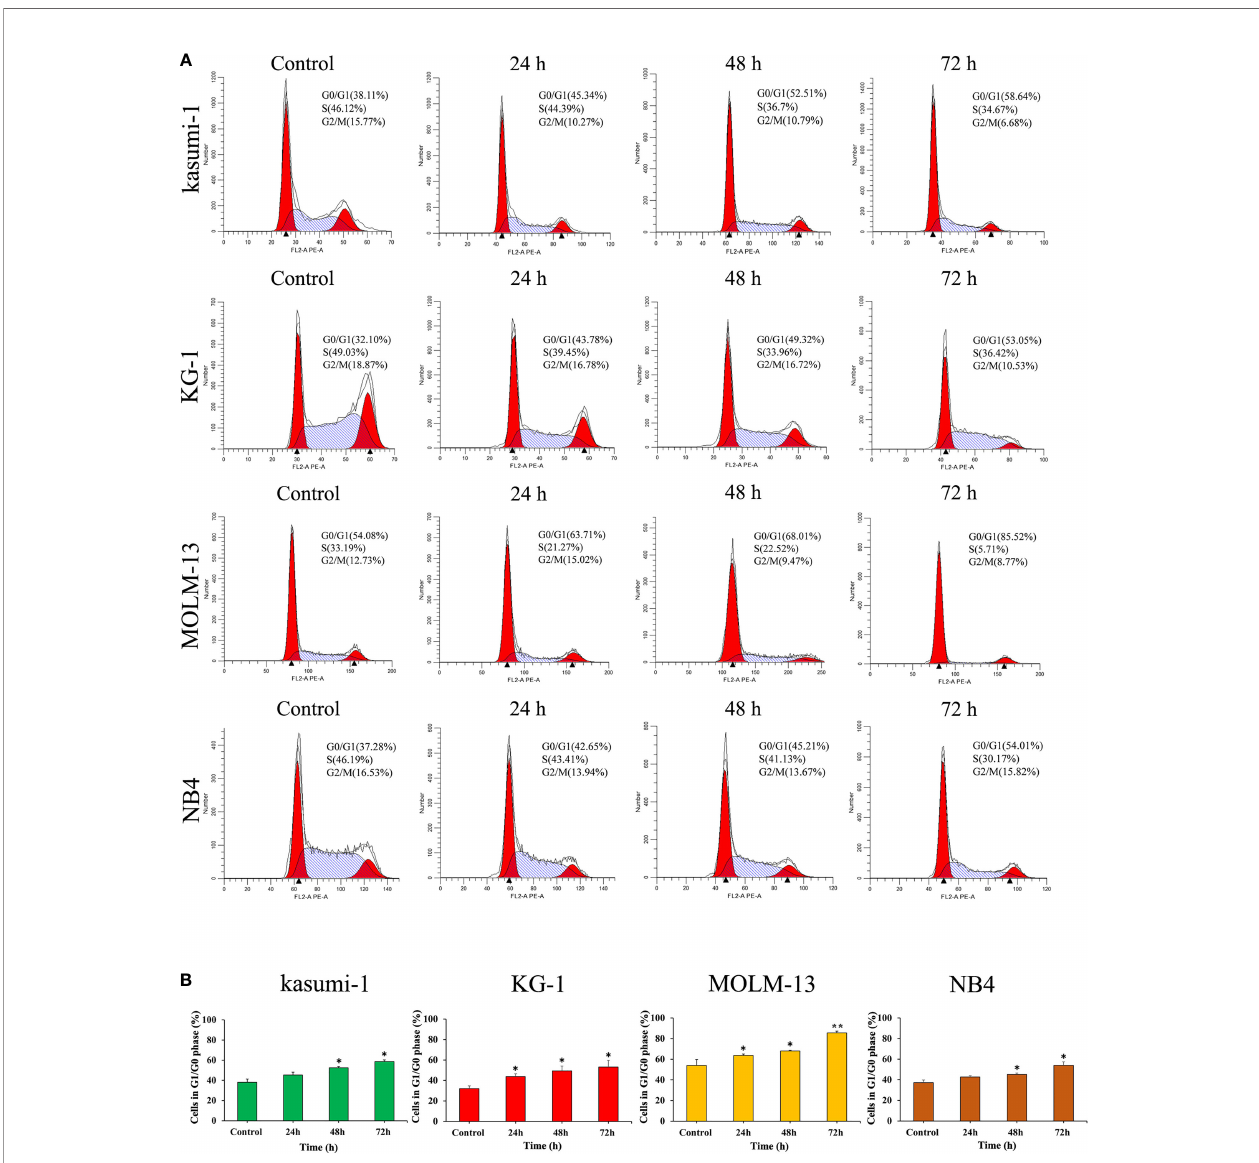
FIGURE 3 | I13 induced the cell-cycle exit in Kasumi-1, KG-1, MOLM-13 and NB4 cells. (A) Kasumi-1, KG-1, MOLM-13 and NB4 cells were treated with I13 at concentrations of 0.5, 0.45, 0.75 or 0.5 µM, respectively, for 24, 48, or 72 h, then stained with PI, and detected by fl ow cytometry. (B) A bar graph showing the percentage of cells at G1/G0 phase (*p < 0.05 and **p < 0.01). The analysis was performed three